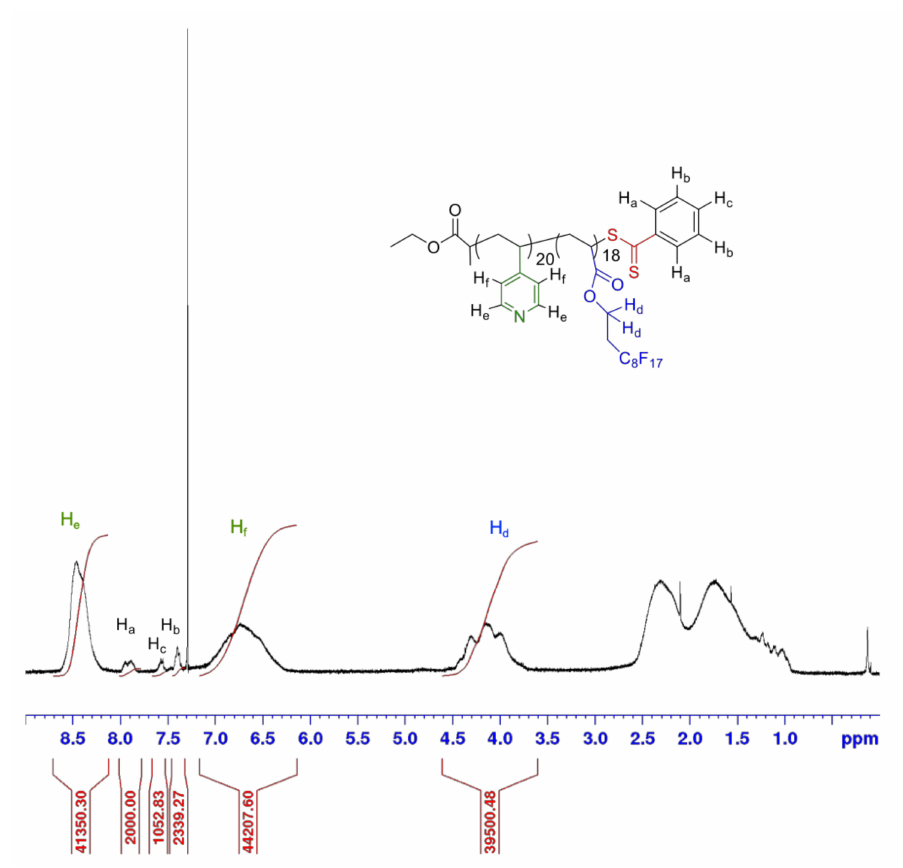
Figure 3. 1 H-NMR spectrum (400 MHz, CDCl 3 ) of P(4VP- co -FDA) after